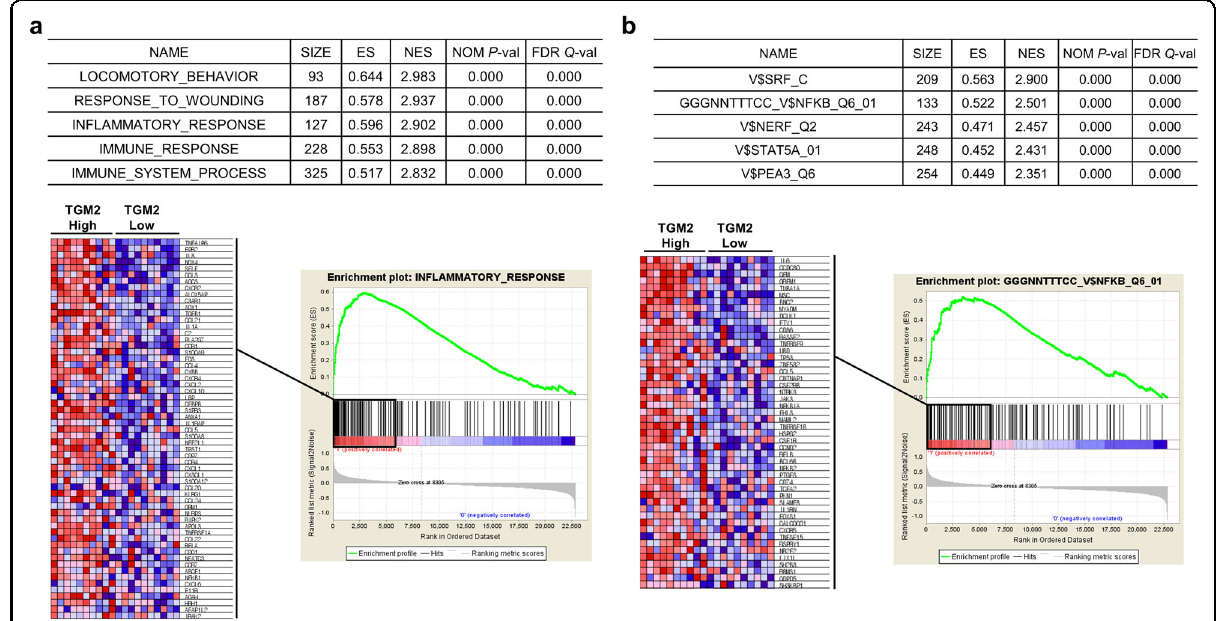
Fig. 3 Gene set enrichment analysis (GSEA) of the mRNA pro fi les for GC samples with the highest expression levels of TGM2 (TGM2_H) and lowest expression levels of TGM2 (TGM2_L). a GSEA using gene ontology (GO) gene sets to compare the TGM2_H ( n = 10) and TGM2_L ( n = 10) groups. Microarray data were downloaded from Gene Expression Omnibus (GEO; GSE27342). The upper table shows the list of the top 5 enriched gene sets in the TGM2_H group with the enrichment score (ES), normalized enrichment score (NES), nominal P -value (NOM P -val) and false discovery rate (FDR Q -val). The lower panel represents the GSEA score curve and enriched genes for the “ INFLAMMATORY_RESPONSE ” gene set. Phenotype “ 1 ” represents TGM2_H samples, and phenotype “ 0 ” represents TGM2_L samples. b GSEA using gene sets from transcription factor- binding motif to compare the TGM2_H ( n = 10) and TGM2_L ( n = 10) groups. Microarray data were downloaded from Gene Expression Omnibus (GEO; GSE27342). The upper table shows the list of the top 5 enriched gene sets in the TGM2_H group with the enrichment score (ES), normalized enrichment score (NES), nominal P -value (NOM P -val) and false discovery rate (FDR Q -val). The lower panel represents the GSEA score curve and enriched genes for the gene set with NF- κ B-binding motifs in the promoter region. Phenotype “ 1 ” represents TGM2_H samples, and phenotype “ 0 ” represents TGM2_L